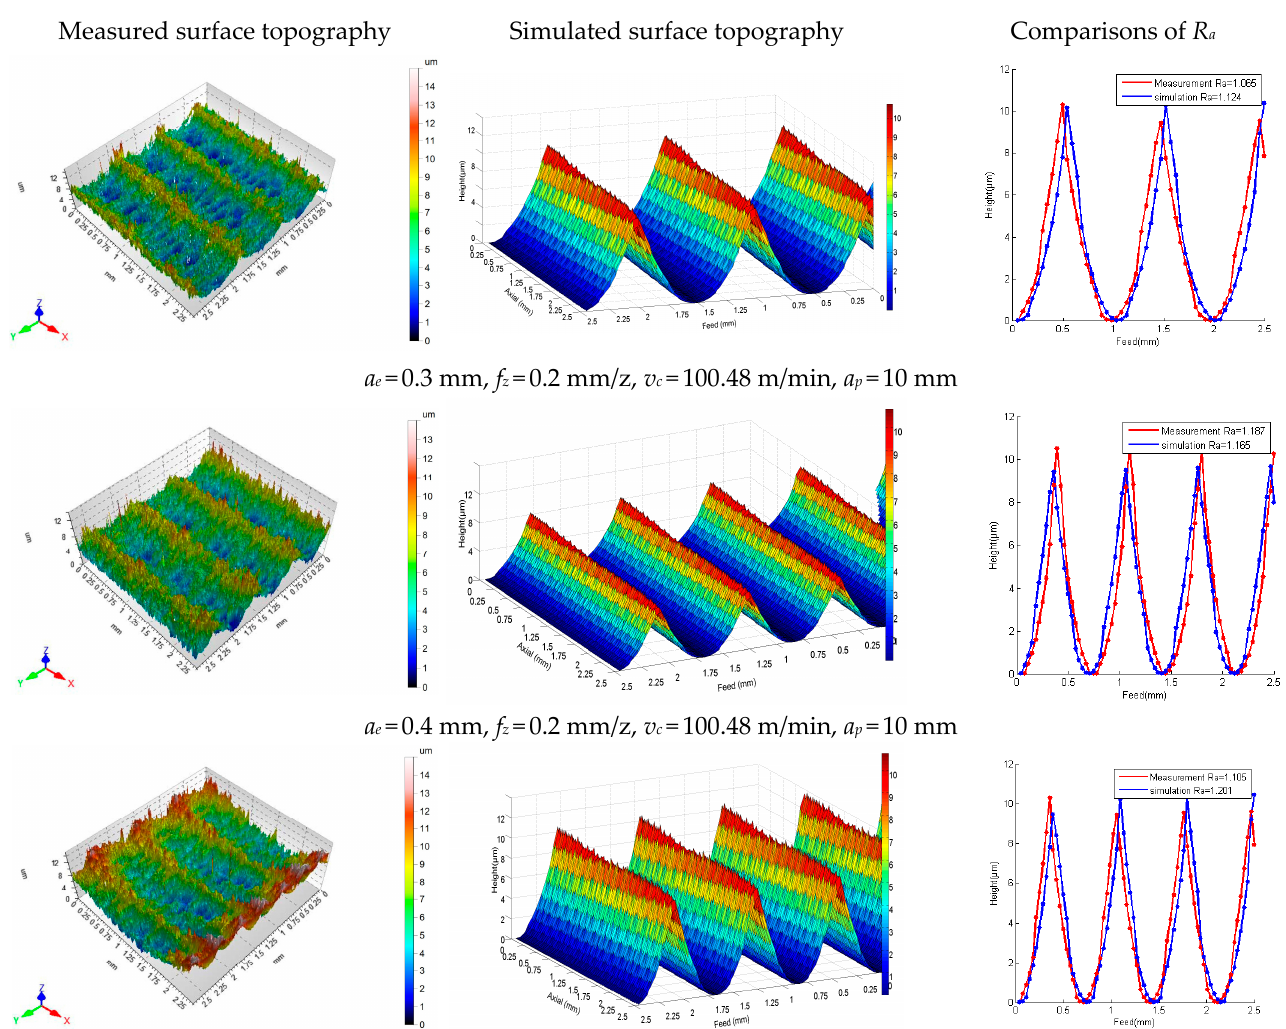
Figure 16. Surface topography of different radial milling depths.